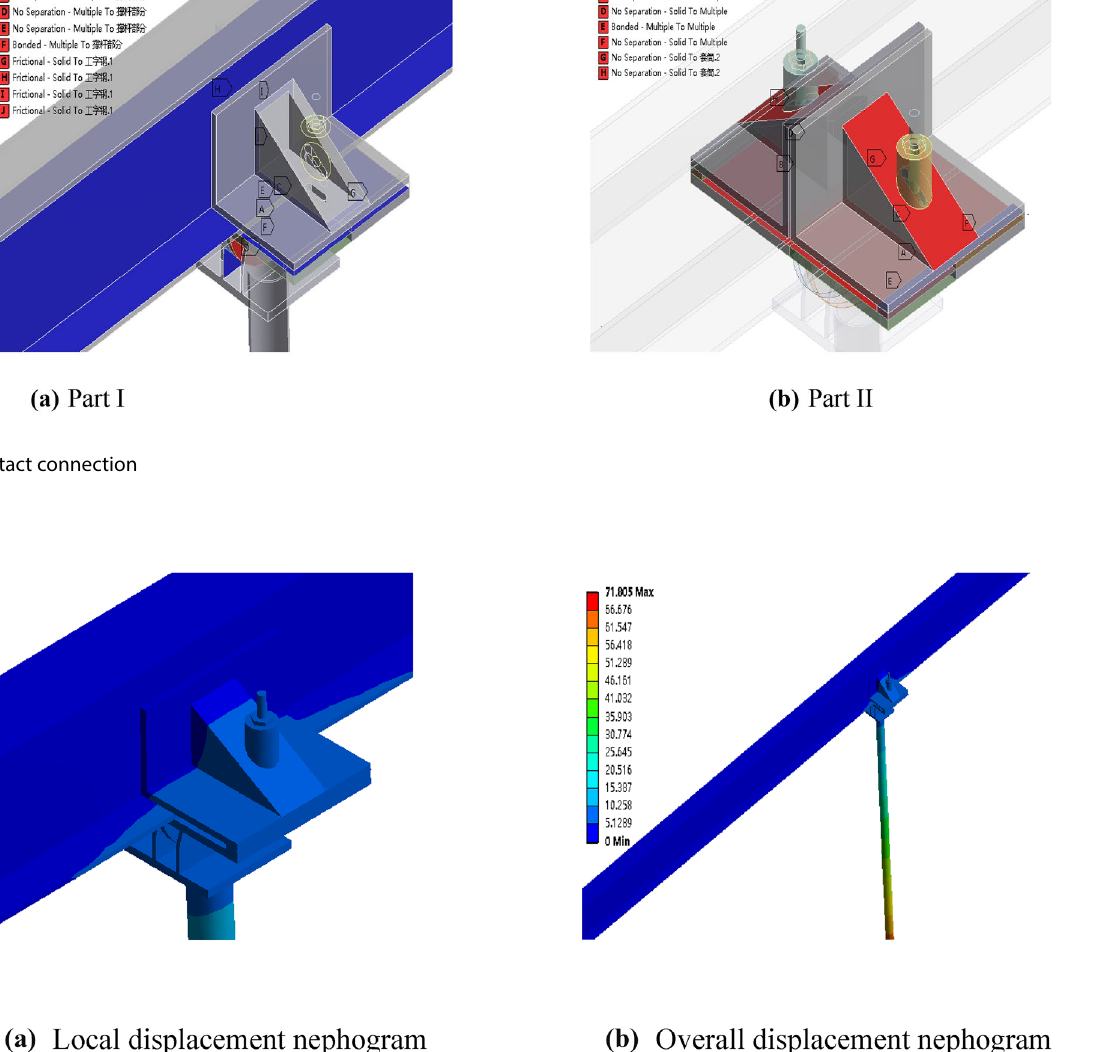
Fig. 10 Displacement